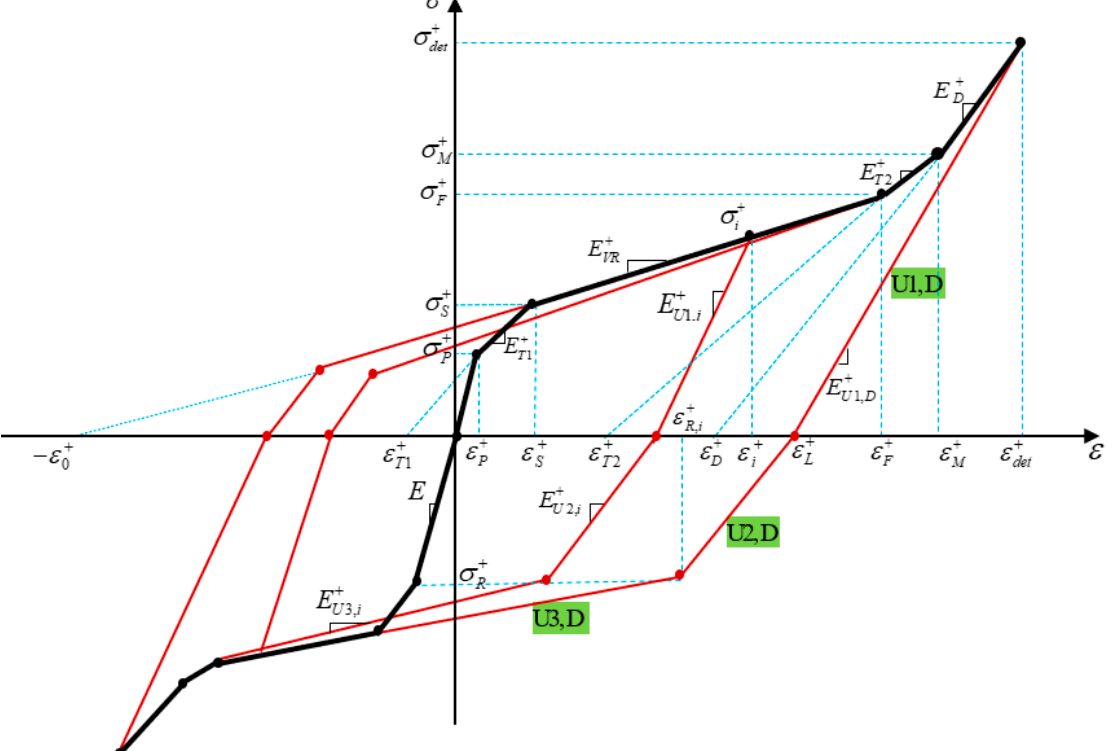
Figure 2. Parametric model to describe the stress–strain relationship of SMA at low temperature.